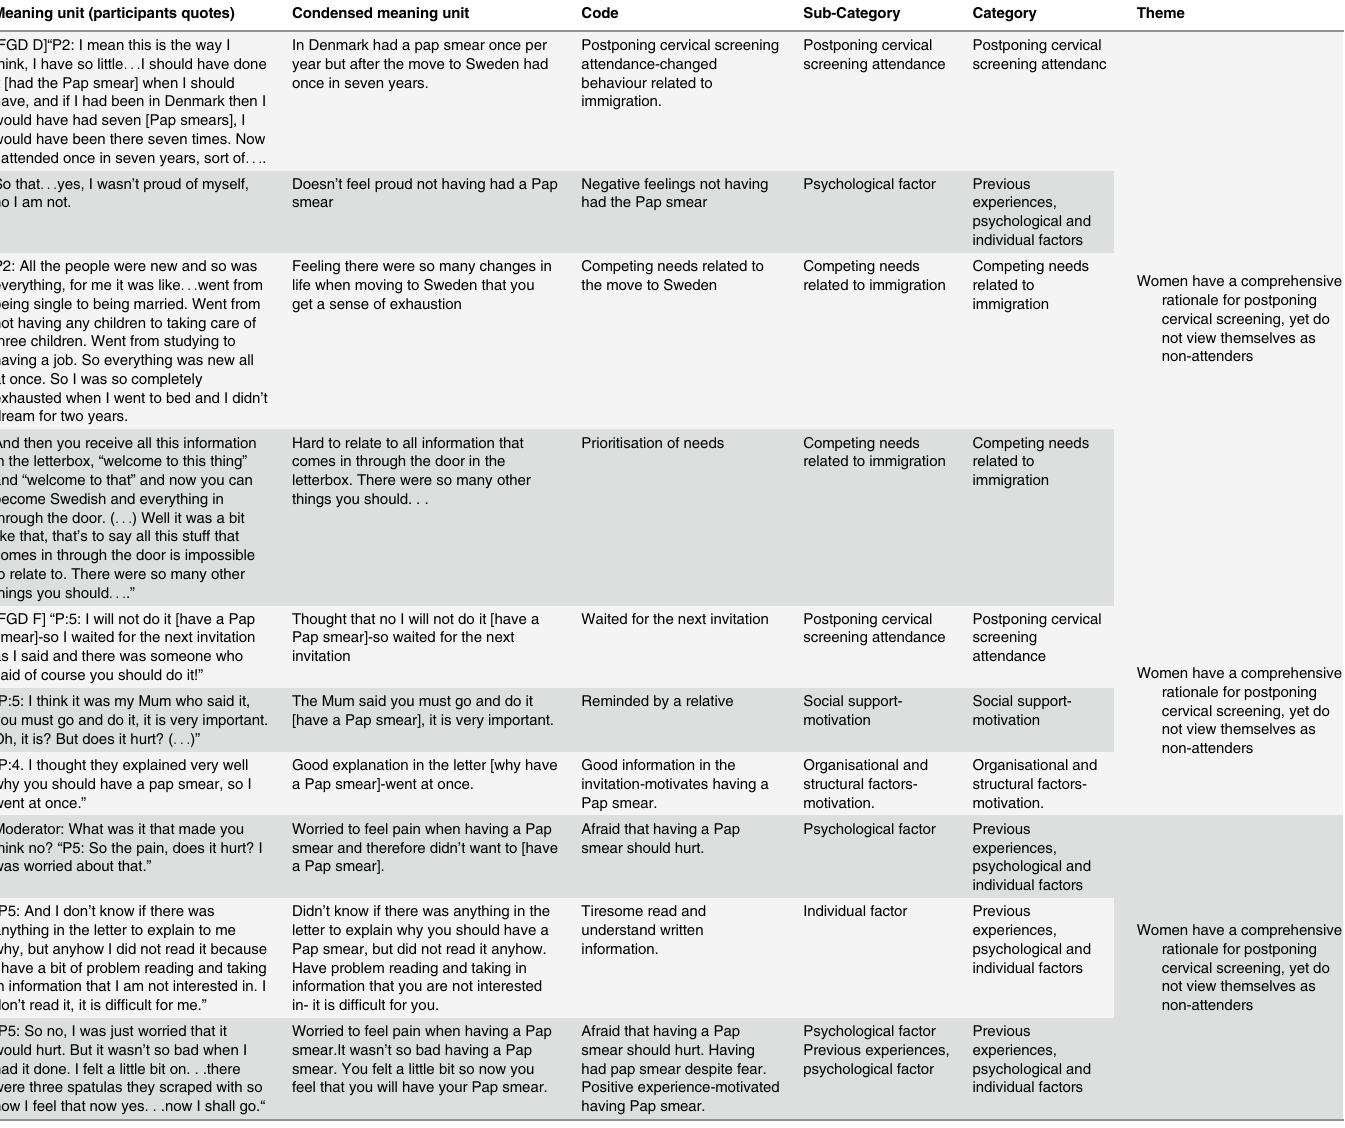
Table 3. Examples of the analytical process. Meaning unit (participants